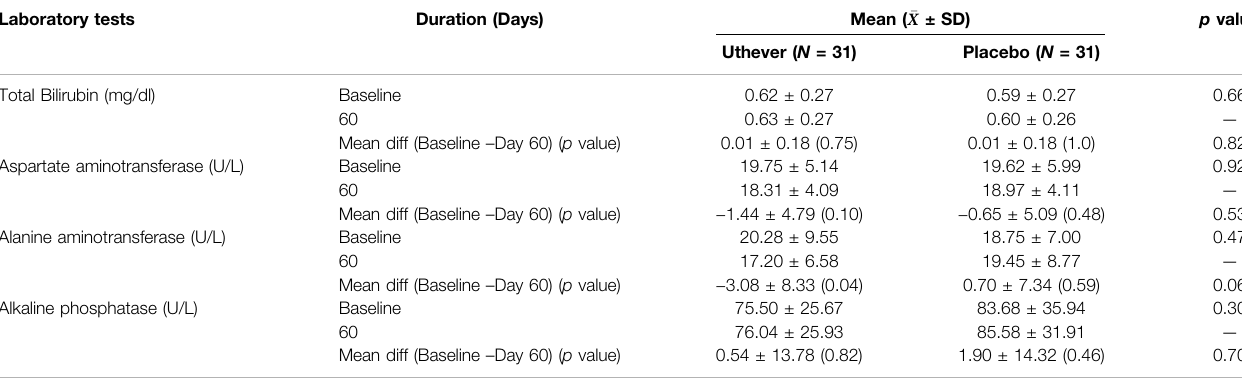
TABLE 11 | Comparison of mean laboratory data (LFT) between groups.